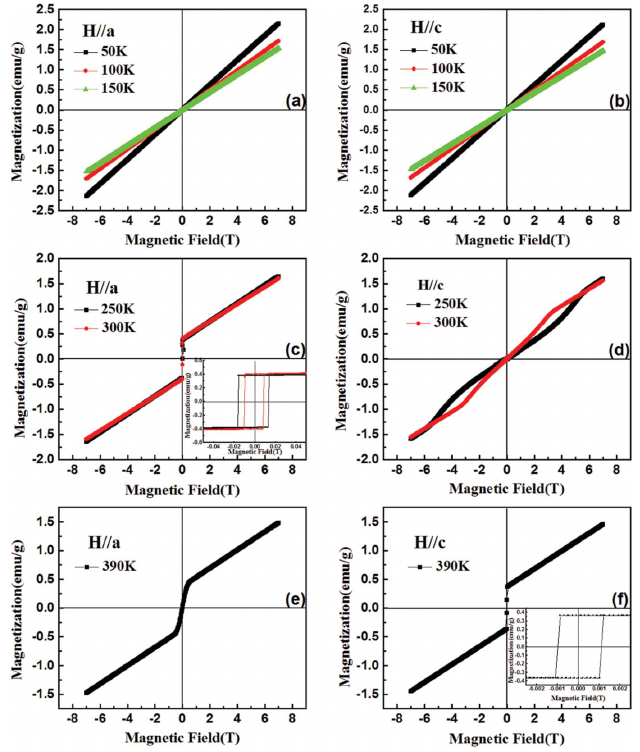
Figure 3 M – H curves for the SmFe 0.75 Mn 0.25 O 3 single crystal along the a and c axes at temperatures of ( a ), ( b ) 50 K, 100 K and 150 K, ( c ), ( d ) 250 K and 300 K, and ( e ), ( f ) 390 K. The insets of ( c ) and ( f ) show enlargements of the plots at small magnetic